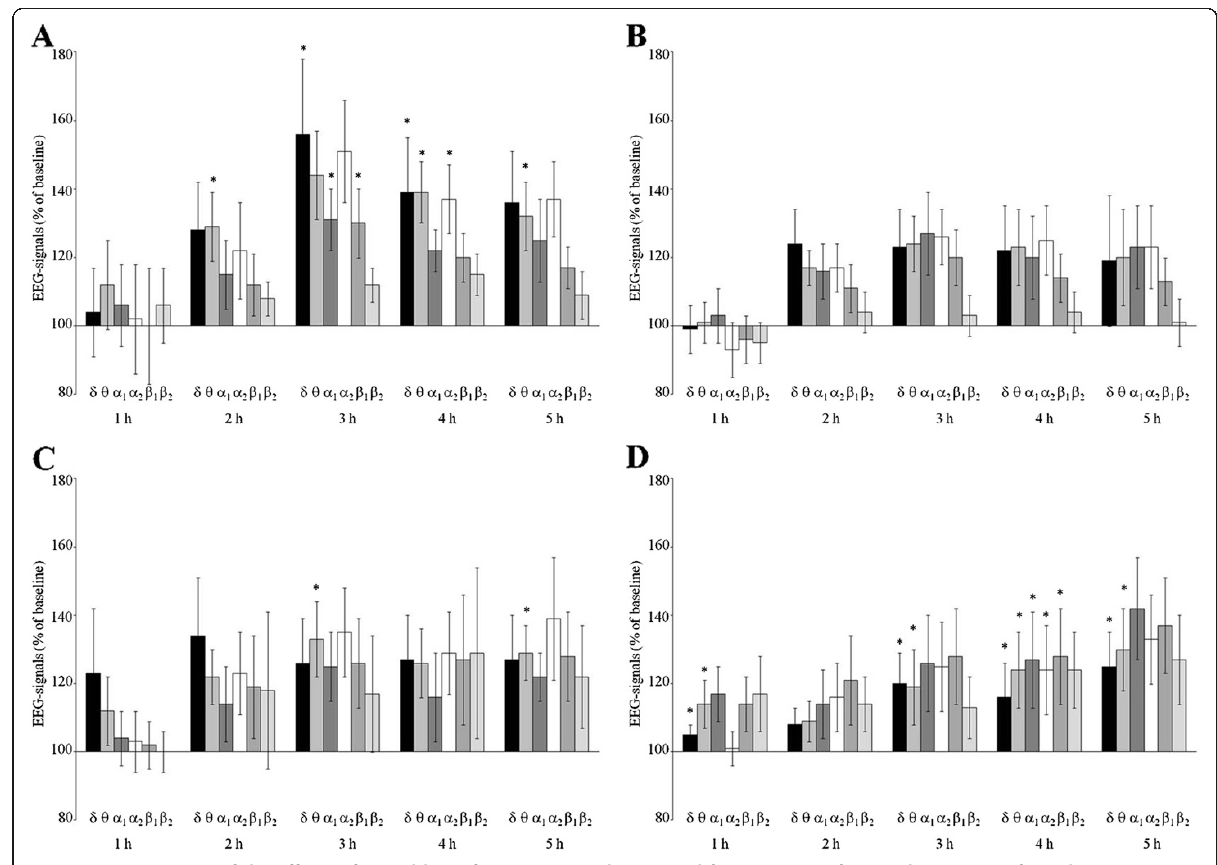
Figure 2 Time course of the effects of 0.5 tablets of Neurexan on the spectral frequencies in four rat brain areas (frontal cortex [A], hippocampus [B], striatum [C], and reticular formation [D]). The electroencephalographic (EEG) signatures were obtained during five experimental intervals of 1 hour (1, 2, 3, 4, and 5 hours). Changes of δ -, θ -, α 1-, α 2-, β 1-, and β 2-waves are presented as percentage of predrug baseline. The data of eight rats are summarized as mean±SEM. Significant differences to vehicle controls (0.9% NaCl) are indicated by asterisks ( P